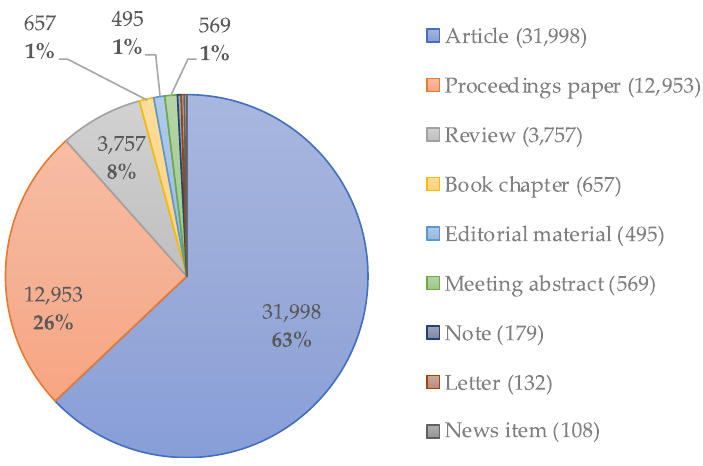
Figure 3. Publishing sources on solar energy research (between 1900 and 2020).